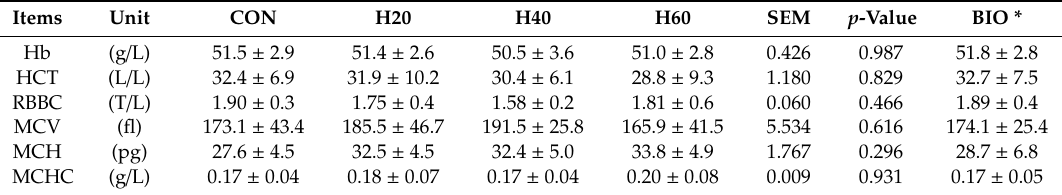
Table 8. Hematological parameters of Eurasian perch fed experimental and commercial control diet (mean ± SD, n =